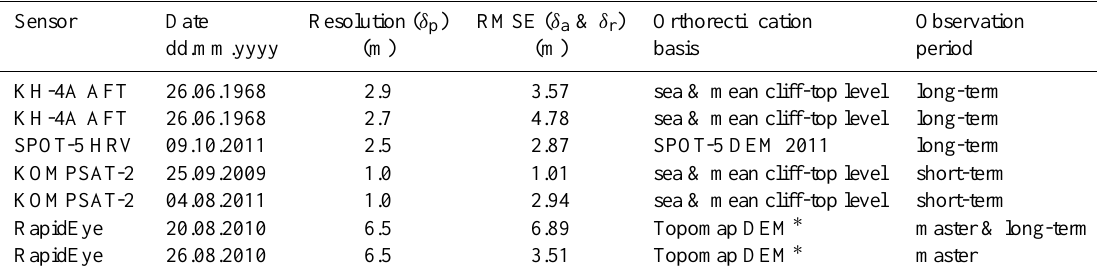
Table 3. List of remote sensing data used for determination of thermo-erosion along Oyogos Yar coast (Dmitry Laptev Strait) and corre- sponding